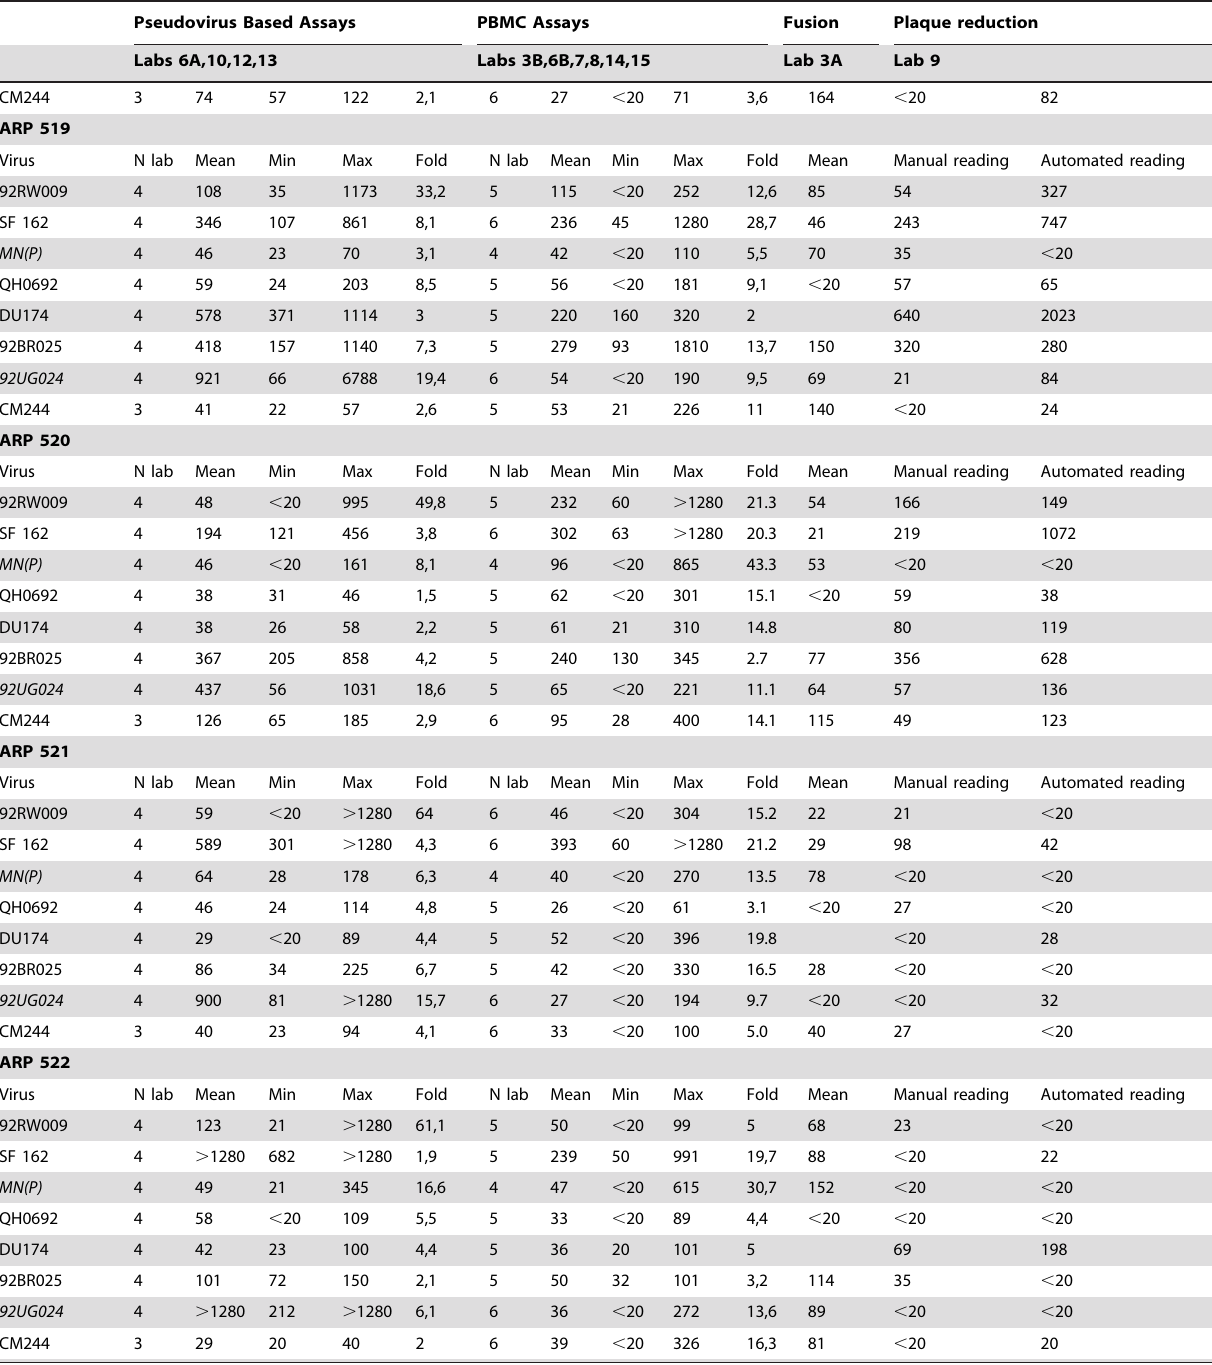
Pseudovirus Based